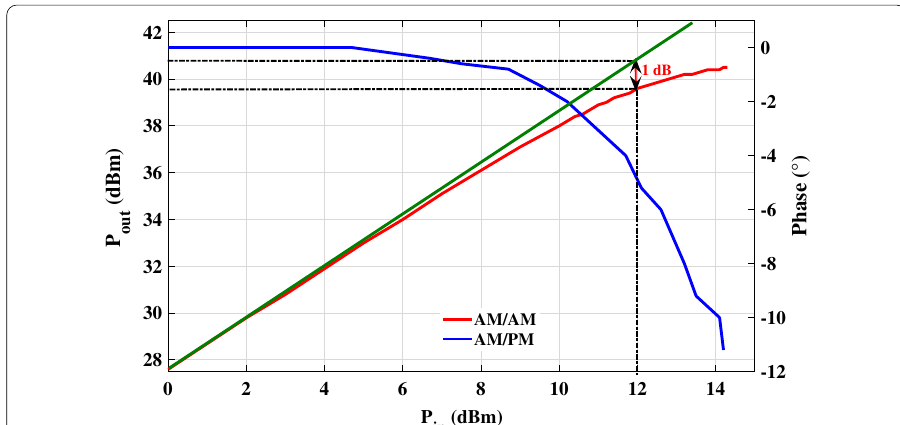
Fig. 18 AM/AM and AM/PM characteristics of the used PA